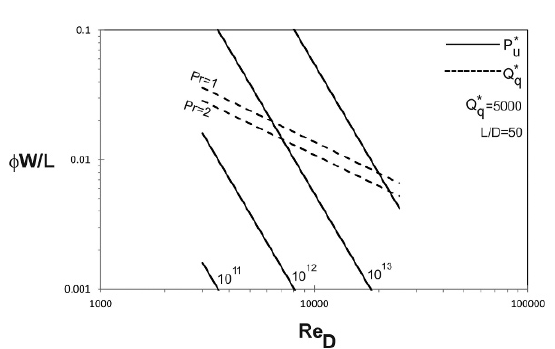
Figure 18. Influence of the Prandtl number on the variation of Φ W/L group with the Reynolds number (turbulent regime and prescribed wall temperature